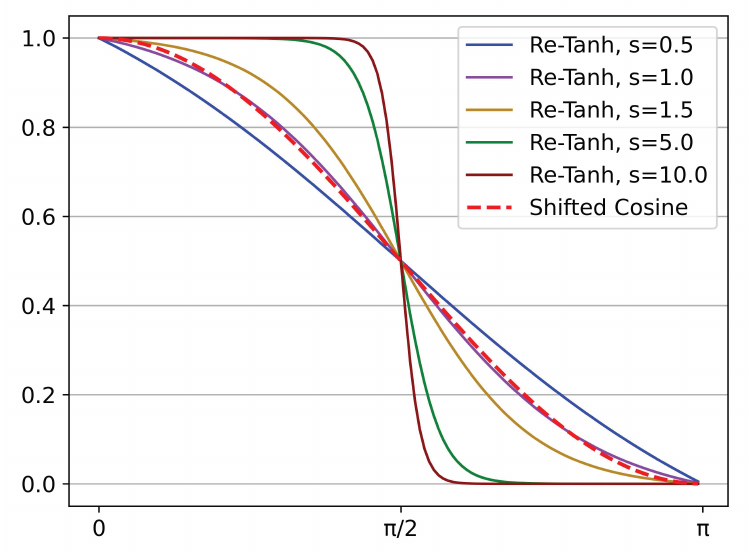
Figure 5. The Re-Tanh curves corresponding to different scale factors. The shifted cosine curve is also illustrated for